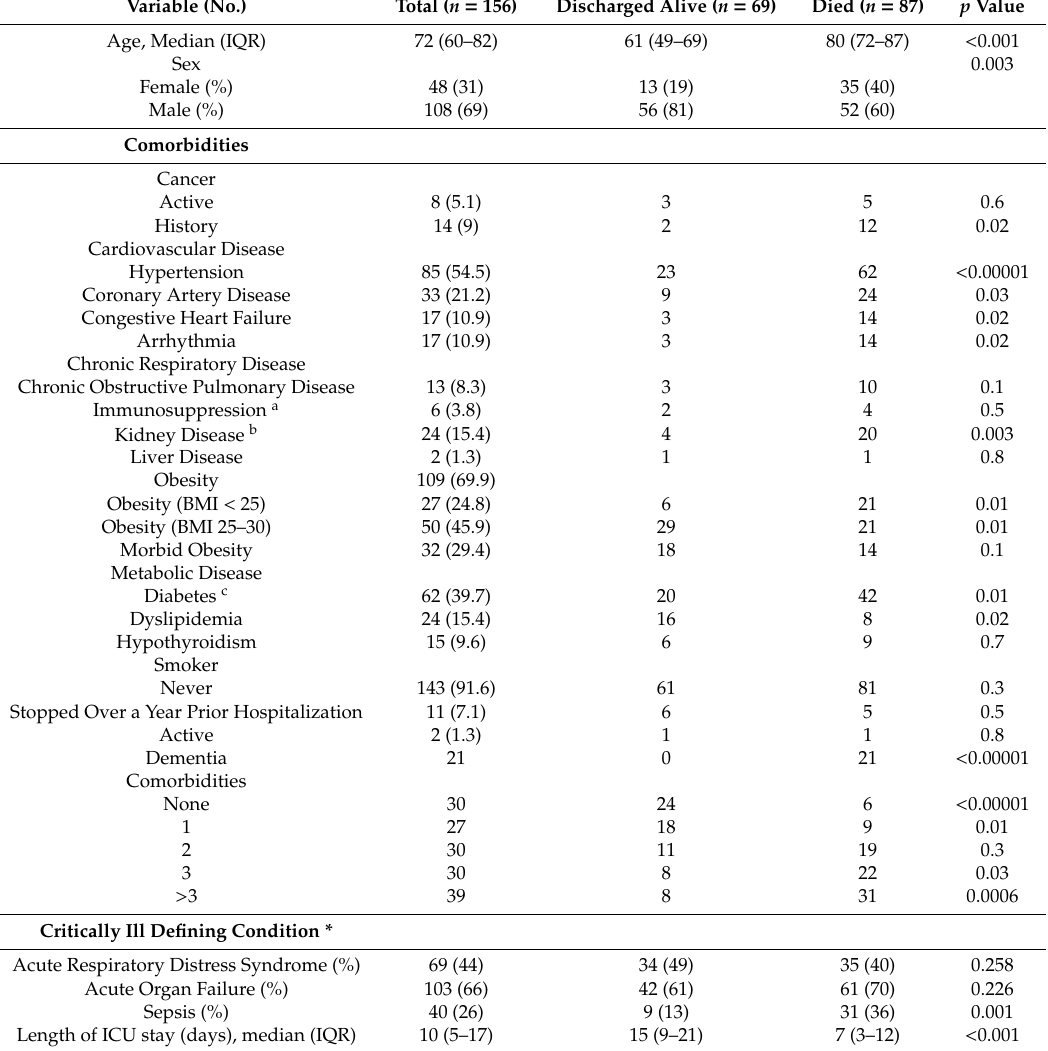
Table1. DemographicandclinicalcharacteristicsofcriticallyillpatientsadmittedtotheICUforCovid-19. Variable (No.)